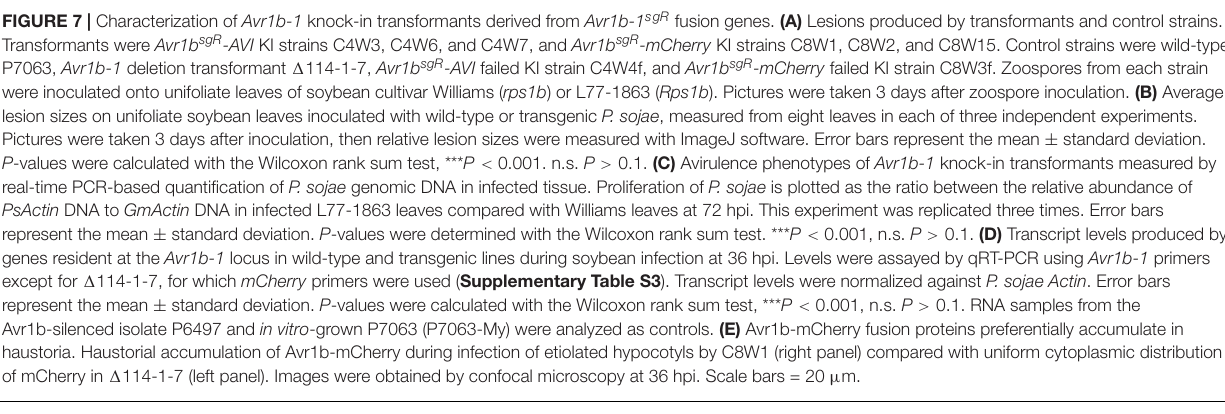
TABLE 1 | Silencing of Avr1b-1 locus in homozygous Avr1b sgR knock-in transformants. Recipient